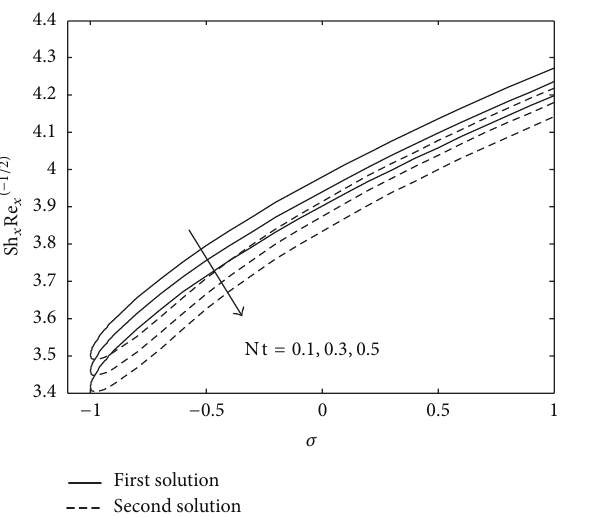
Figure 6: Variations of the local Sherwood number (concentration rates) with 𝜎 for different values of Nt when Nb = 0.5, Le = 2, Pr = 6.8, 𝛾 = 0.1, and S = 2.